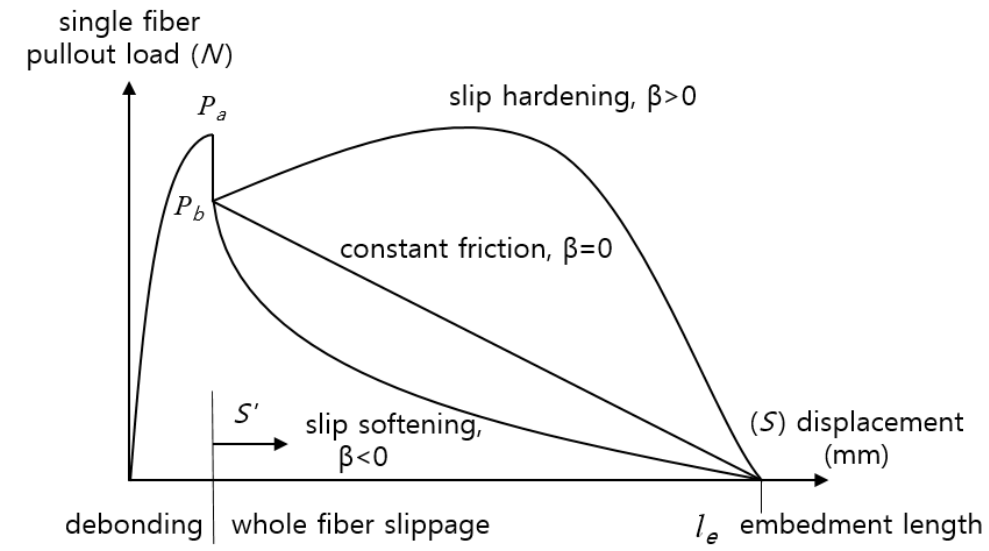
Figure 2. General profile of a single fiber pullout curve [17].